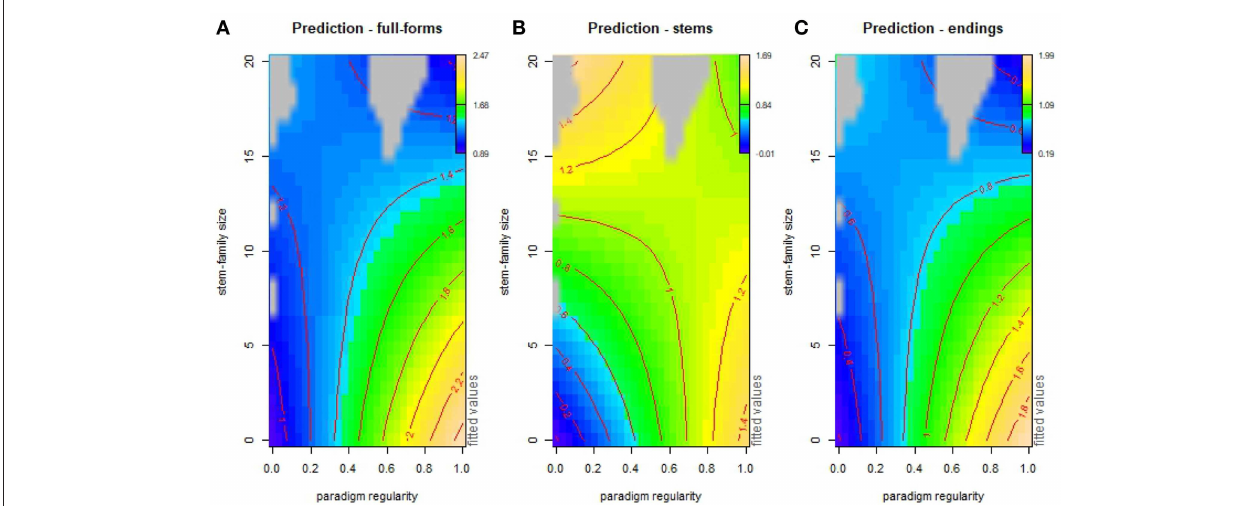
FIGURE 9 | Contour plots of additive interaction effects of stem-family size and paradigm regularity on word (A) , stem (B) , and ending (C) prediction ( itsadug package, fvisgam function). Grid points at a distance of ≥ 0.2 from the predictor variables are excluded (gray areas).